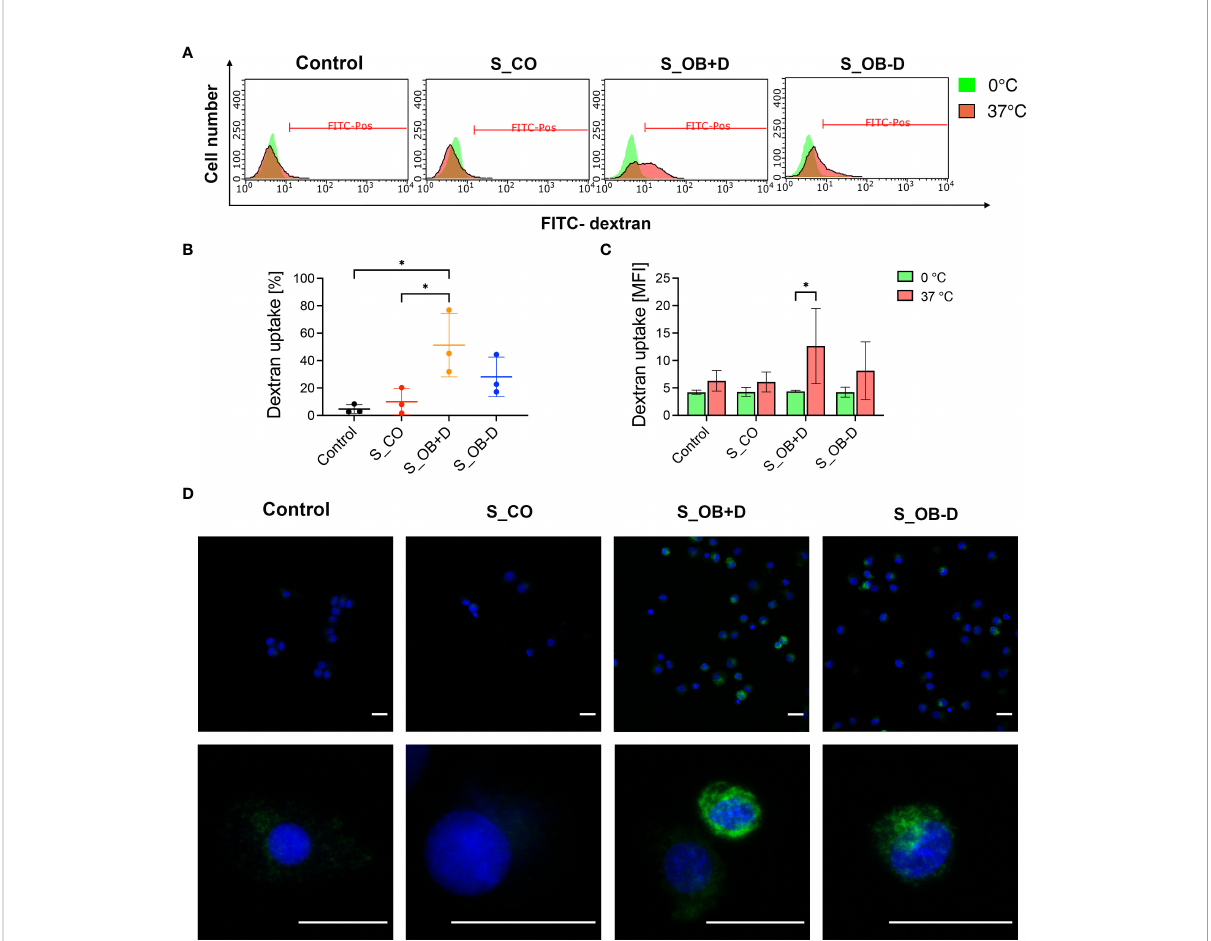
FIGURE 4 Effects of JPC secretomes on the dextran uptake ability of maturated MoDCs. DCs generated by indicated treatments (without secretomes or after the addition of 5-fold concentrated JPC secretomes) were incubated with 1 mg/mL FITC-dextran either on ice (0°C) or within an incubator (37°C) for 1 hour and analyzed by fl ow cytometry and fl uorescence microscopy. (A) Representative FACS graphs of three independent experiments. (B) Percentage of dextran-positive DCs. (C) Mean fl uorescence intensity (MFI) of dextran uptake by DCs on ice and at 37°C. Results of three independent experiments are given as means ± SD and compared using one-way ANOVA followed by Tukey ’ s multiple comparisons tests (n=3, *p<0.05). (D) Microscopic fl uorescence images of FITC-dextran uptake (green) by DCs. Cell nuclei were stained by DAPI (blue). Scale bars represent 20